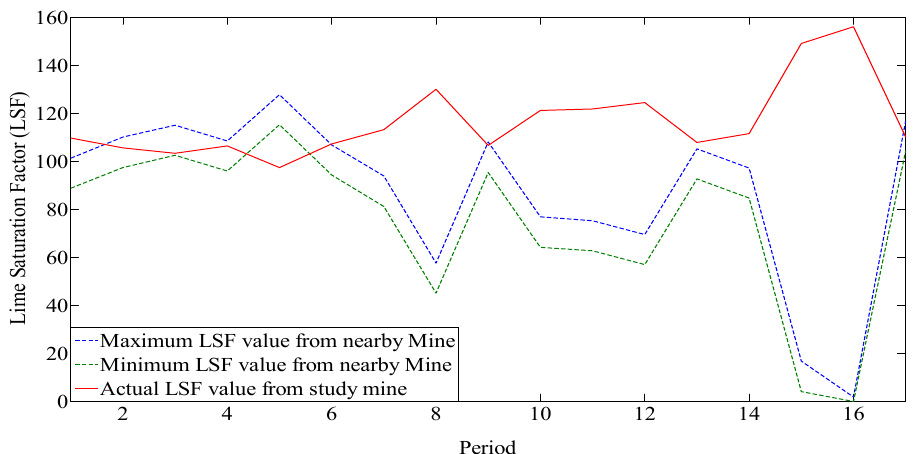
Figure 11. Model 2 LSF value for 17 periods with LSF bound.